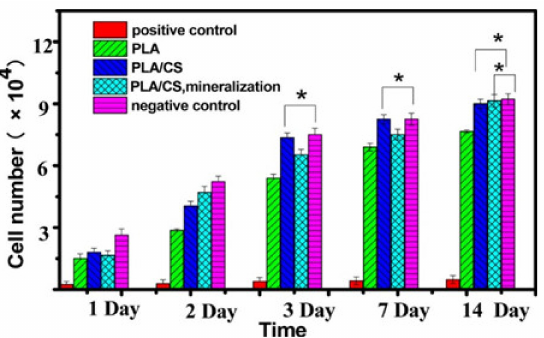
Figure 10. CCK-8 assay of MC3T3-E1 cells in the extract of pure PLA, PLA/CS 70:30, and mineralized PLA/CS scaffolds after culturing for 1, 2, 3, 7, and 14 days (* p > 0.05). Reprinted with permission from ref. [225]. Copyright 2017